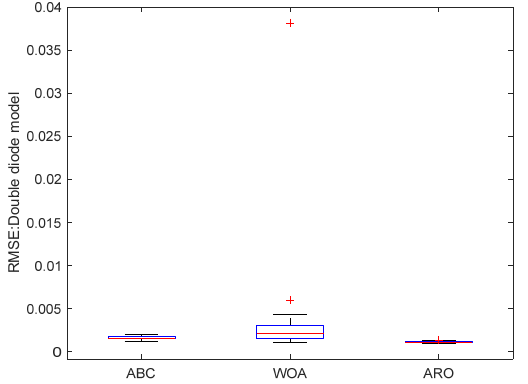
Figure 10. Boxplot graph obtained by various algorithms.